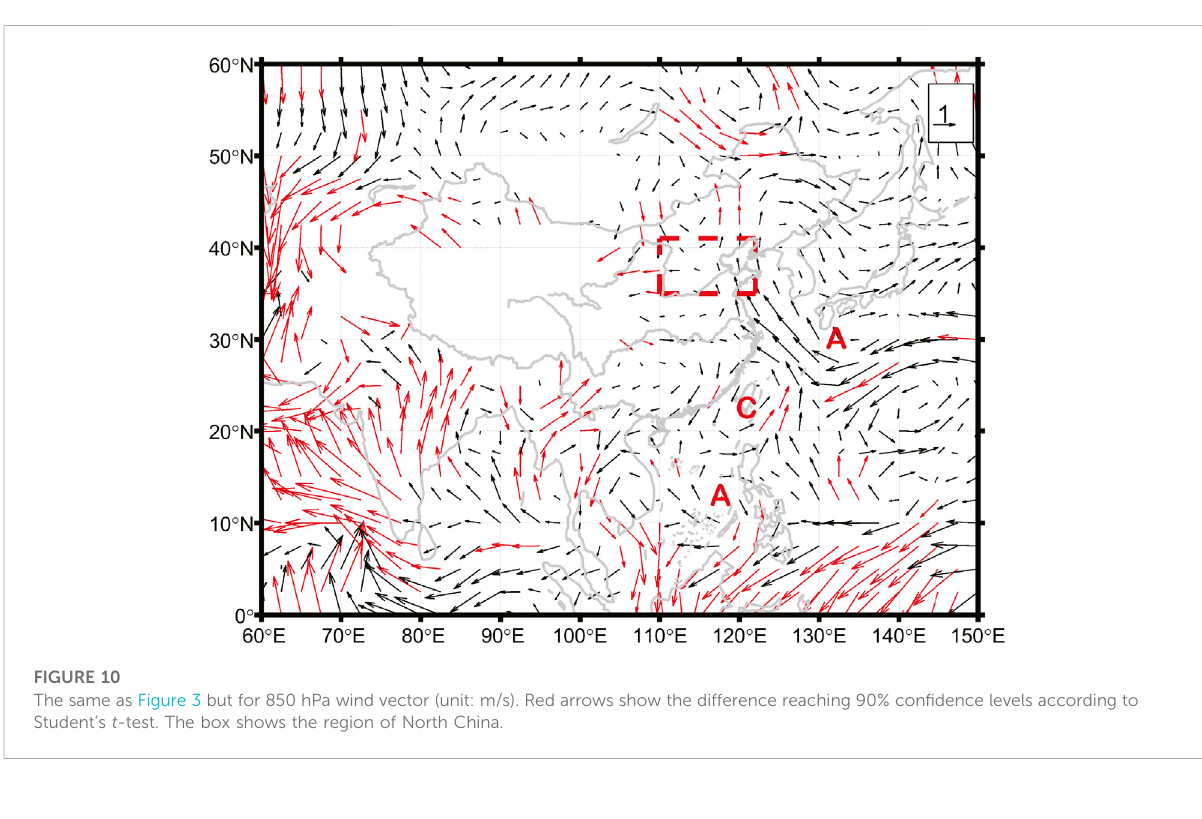
FIGURE 10 The same as Figure 3 but for 850 hPa wind vector (unit: m/s). Red arrows show the difference reaching 90% con fi dence levels according to Student ’ s t -test. The box shows the region of North China.